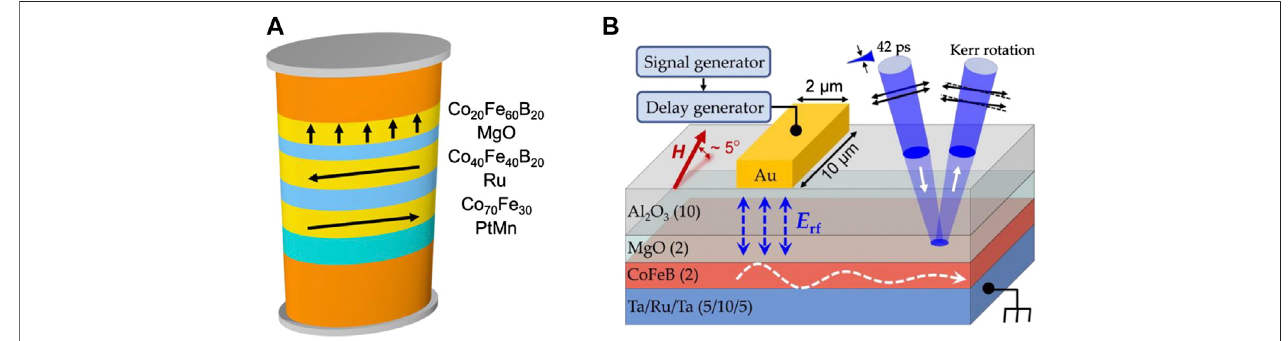
FIGURE 3 | Spin-wave excitation devices based on VCMA. (A) Schematic diagram of nonlinear parameter excitation device. Due to iPMA, Co 20 Fe 60 B 20 magnetization equilibrium direction isperpendicularto theplane. In cases where the microwave voltage frequency applied bythe top electrode istwice ofthe spin-wave frequency, short wavelength spin waves are excited (Chen et al., 2017). Reprinted with the permission from Chen, Y.-J., Lee, H.K., Verba, R., Katine, J.A., Barsukov, I., Tiberkevich, V., et al. (2017). Parametric resonance of magnetization excited by electric fi eld. Nano letters 17 (1), 572-577. Copyright 2017 American Chemical Society. (B) Schematic diagram of linear parameter excitation device: applying an RF voltage on Au electrode to locally excite spin waves (Rana et al., 2017) (licensed under CC BY